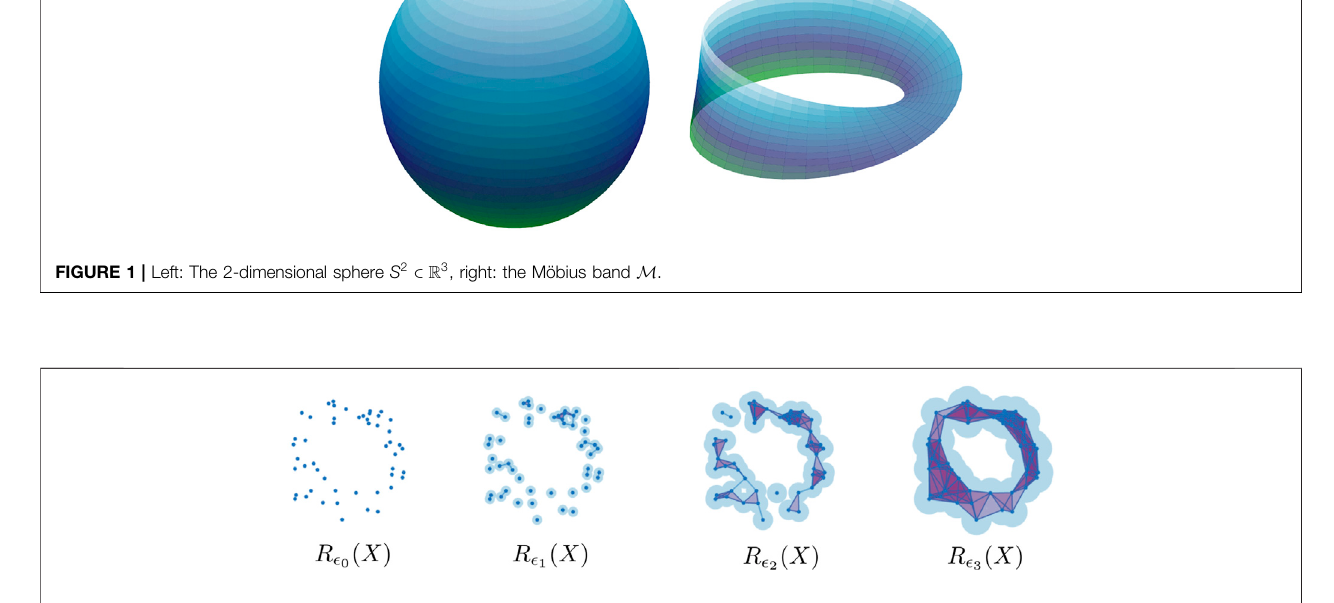
FIGURE 2 | The Rips complex on a point cloud ( X , d X ) sampled around the unit circle, for four different scale choices.